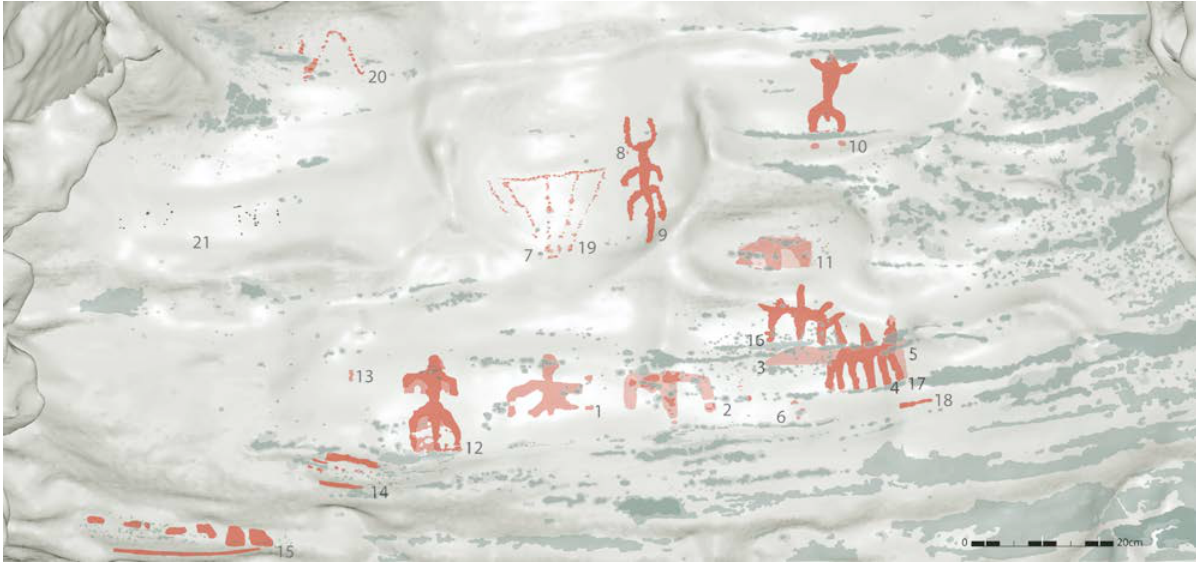
Figure 12. Drawings of the parietal representations visible in the Grotta Scritta 1 (Olmeta-di-Capocorso, Corsica, France). In red: painted elements (n°1 à 20); in grey: modern graffiti (n°21); in grey-green: lichens. The recording is based on orthophotos processed in Figures 8 and